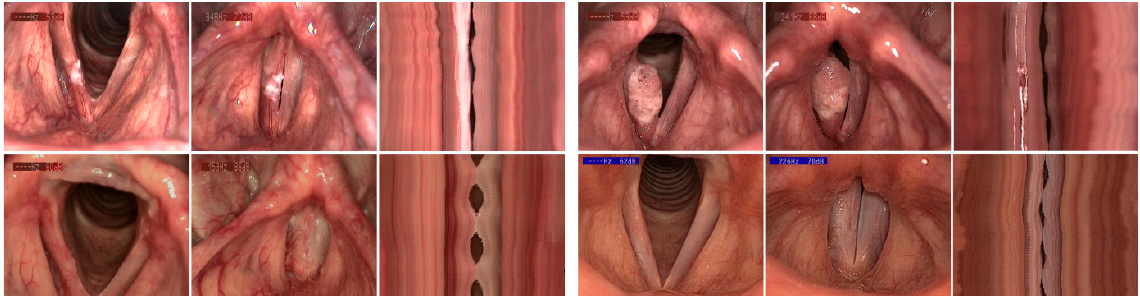
Figure 1. Videolaryngostroboscopic pictures and videostrobokymographic illustration of vocal fold anatomy and function, preoperative ( upper row ) vs. postoperative ( lower row ). Example A ( left side ): 45-year-old male professional theater actor with a flat hyperkeratotic lesion of the right vocal fold. Example B ( right side ): 32-year-old female medical doctor with an exophytic tumor of the right vocal fold. Findings three months postoperatively show: pT1a completely removed, healing process finished, vocal folds with straight margin, complete glottal closure, and restored phonatory mobility (A: normalized, regular and symmetric oscillations; B: oscillations with scarring-related reduced amplitude and phase shift).